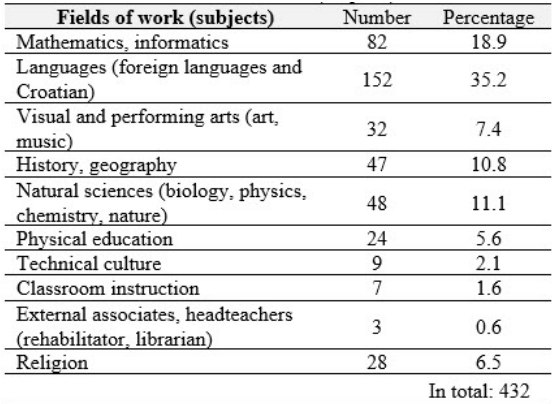
Table 2. Field of work of